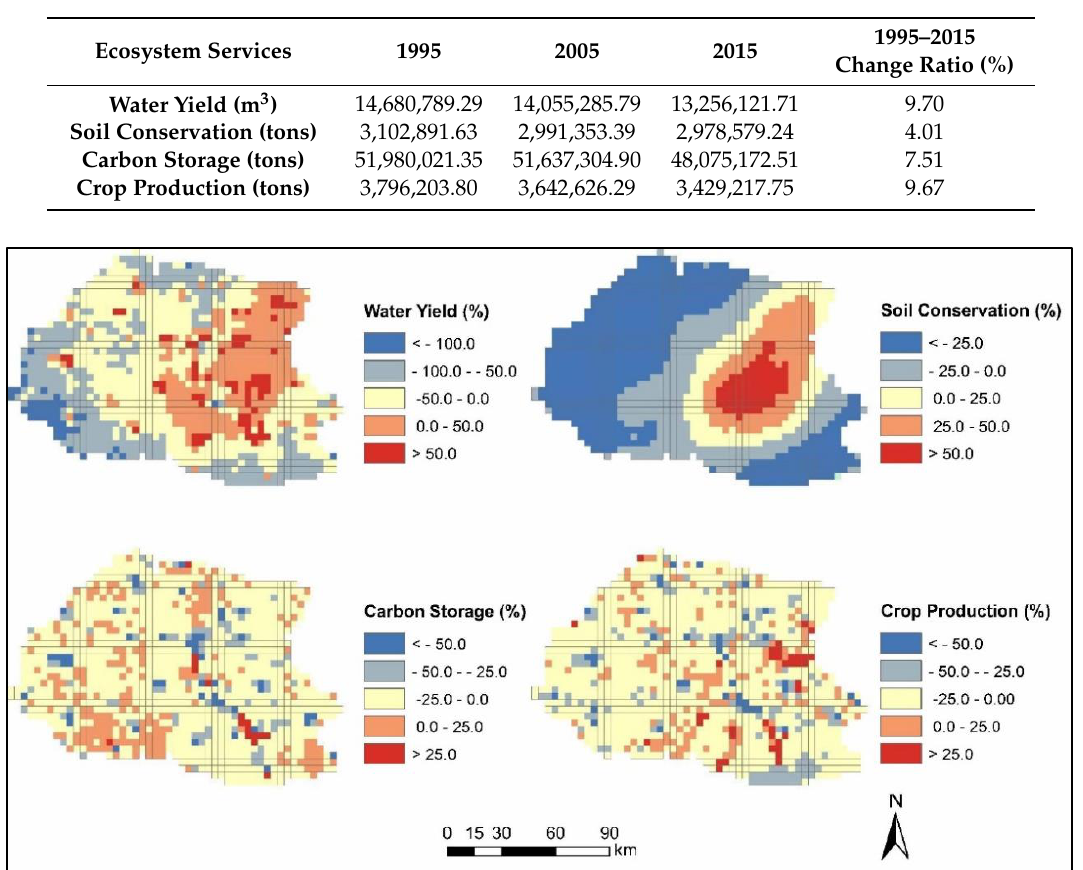
Table 6. Ecosystem services values in the NLB from 1995 to 2015.